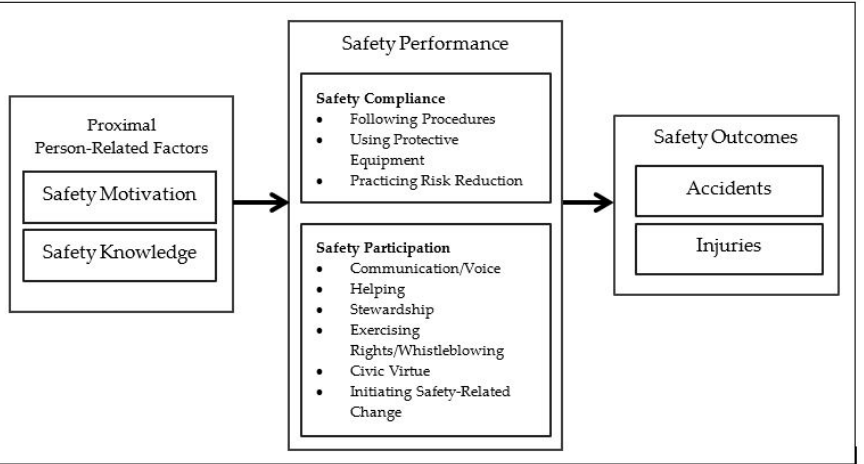
Figure 1. Adapted integrative model of workplace safety [23]. Adapted with permission from Christian, M.S.; Bradley, J.C.; Wallace, J.C.; Burke, M.J. (2009). 2021 Michael Christian.